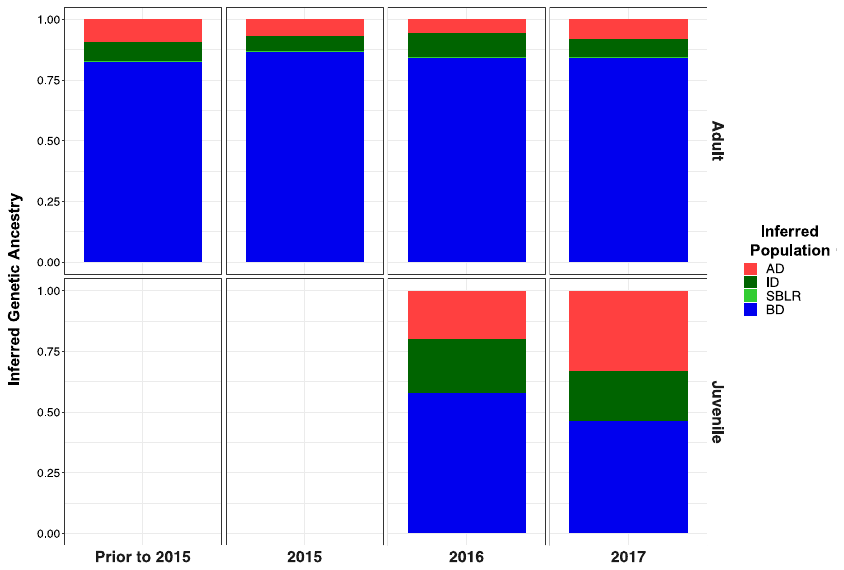
Figure 5. Inferred proportion of genetic ancestry from each of the four reference populations across recolonizing adult steelhead and juvenile smolt life history cohorts. Colors are representative of the inferred population. The bottom x axis divides life history cohorts temporally and the right y axis divides them by life history stage. We included the South Branch of the Little River (SBLR) as a control because we did not expect to see assignment to that